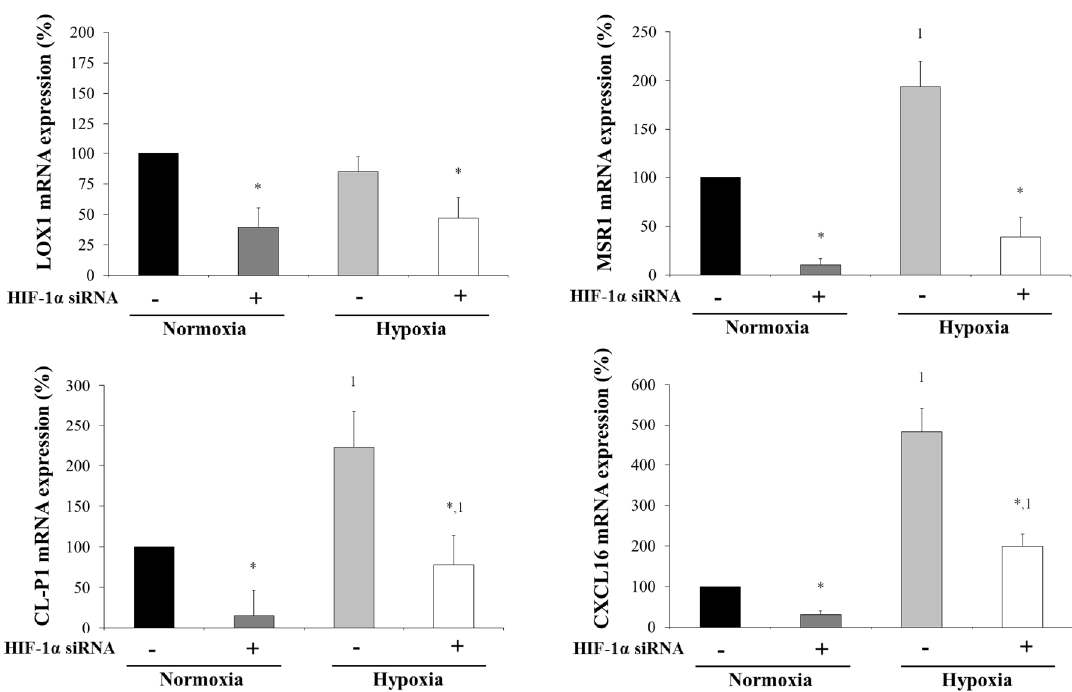
Figure 6. Levels of HIF-1 α , GLUT1, TNF α , IL6 and scavenger receptors mRNA expression (%) of in vitro-differentiated adipocytes obtained from human mesenchymal stem cells of visceral adipose tissue (VAT) from non-obese subjects ( n = 5) incubated in normoxia and hypoxia conditions when HIF-1 α was silenced as described in the Materials and Methods section. Briefly, at day 15 of adipocyte differentiation, the transfection was made with a siRNA (s6539) and DharmaFECT TM Transfection Reagent. After 24 h in the normoxia condition, the cells were incubated for another 24 h in normoxia or hypoxia conditions. Cells were harvested and frozen at − 80 ◦ C until analysis. Each treatment was performed in triplicate. Data are the mean ± SEM. Results are shown as a percentage with regard to normoxia condition (100%) without hypoxia and HIF-1 α silencing. * p < 0.05: significant differences between silenced and not silenced HIF-1 α conditions. 1 p < 0.05: significant differences between normoxia and hypoxia conditions when HIF-1 α is or is not silenced.